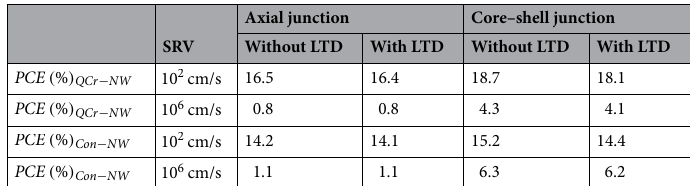
Axial junction Core–shell junction SRV Without LTD With LTD Without LTD With LTD PCE ( % ) QCr − NW 10 2 cm/s